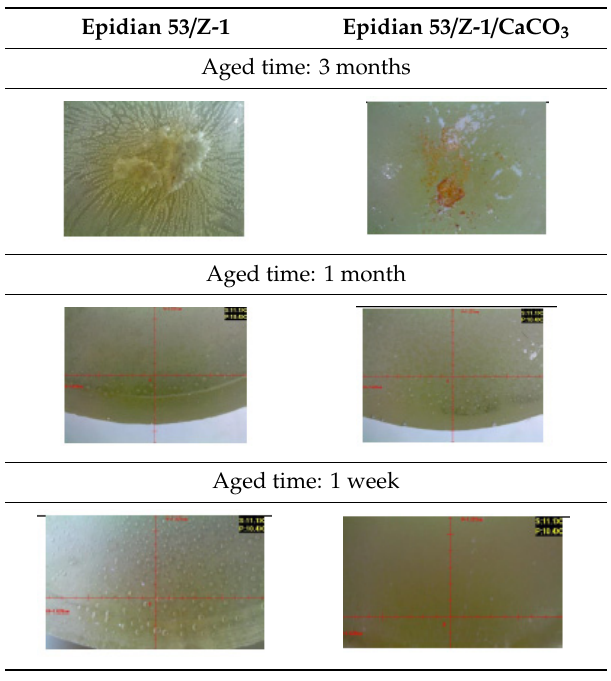
Table 9. Samples aged in 1 / 4 reference salinity environment. Table 9. Samples aged in 1/4 reference salinity environment. Table 9. Samples aged in 1/4 reference salinity environment. Table 9. Samples aged in 1/4 reference salinity environment. Table 9. Samples aged in 1/4 reference salinity environment. Table 9. Samples aged in 1/4 reference salinity environment. Table 9. Samples aged in 1/4 reference salinity